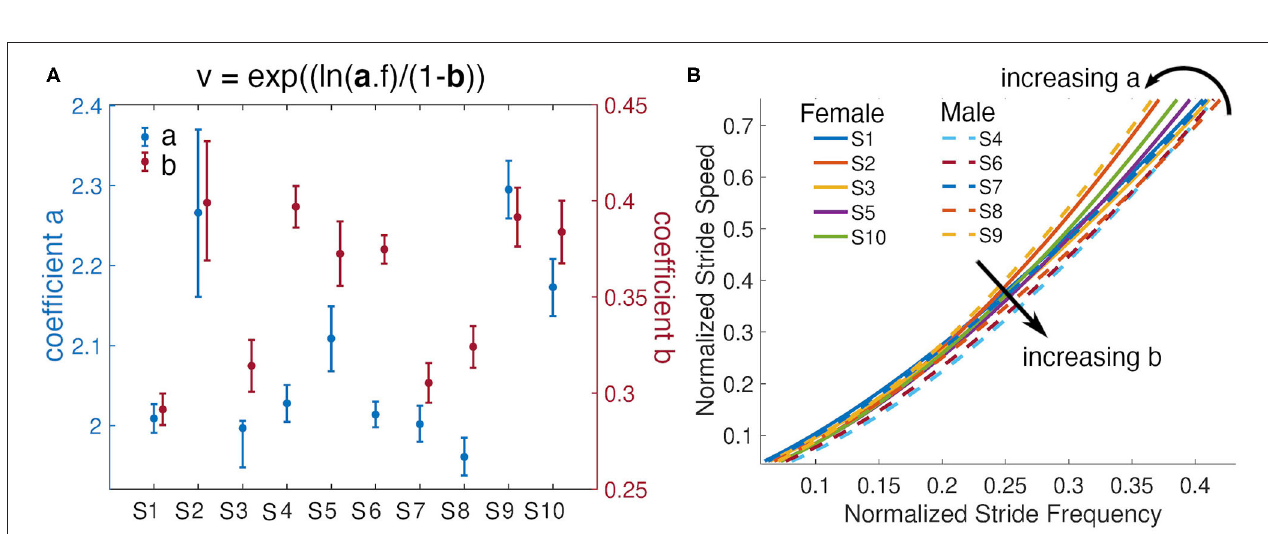
FIGURE 7 | Subjects’ models and their parameters. (A) Parameters a and b from each subjects power model and their 95 % confidence intervals. (B) Fitted lines for all subjects and visualization of the effects of variations of the parameters a and b . Females are represented with solid lines and males with dashed lines.